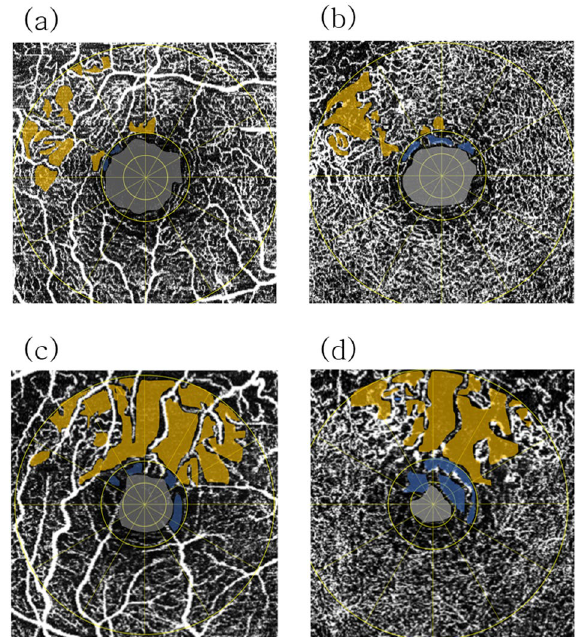
Figure 4. Schematic NPA images in ( a , b ) a 56-year-old female from the recurrence group and ( c , d ) a 57-year- old female from the nonrecurrence group. ( a ) The NPA3 (yellow area) and NPA1 (gray area plus blue area) of the SCP in this recurrence case were 0.414 mm 2 and 0.564 mm 2 , respectively. ( b ) The NPA3 (yellow area) and NPA1 (gray area plus blue area) of the DCP in this recurrence case were 0.571 mm 2 and 0.531 mm 2 , respectively. ( c ) The NPA3 (yellow area) and NPA1 (gray area plus blue area) of the SCP in this nonrecurrence case were 1.585 mm 2 and 0.359 mm 2 , respectively. ( d ) The NPA3 (yellow area) and NPA1 (gray area plus blue area) of the DCP in this nonrecurrence case were 1.435 mm 2 and 0.281 mm 2 ,